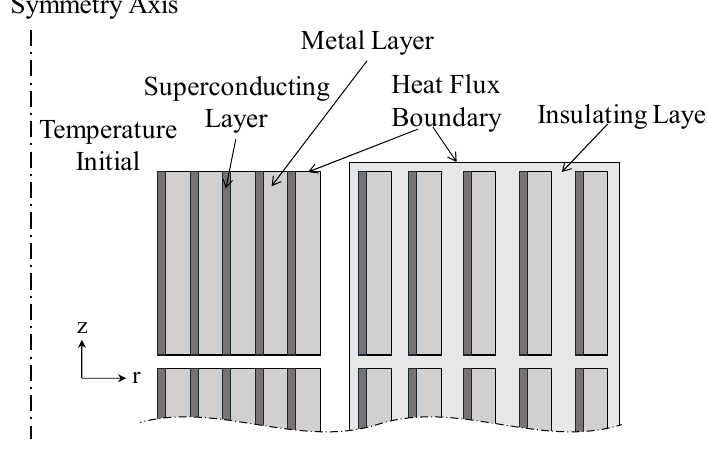
Figure 4. Schematic diagram of heat transfer model.